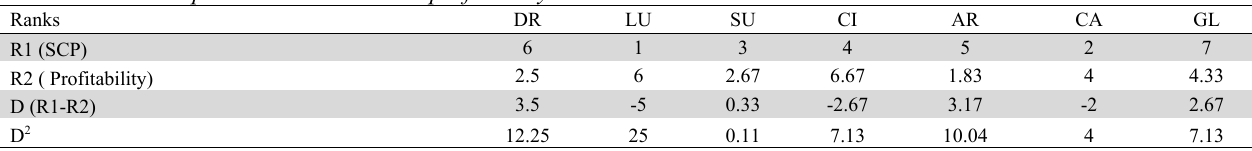
Relative relationship between av. SCP and profitability